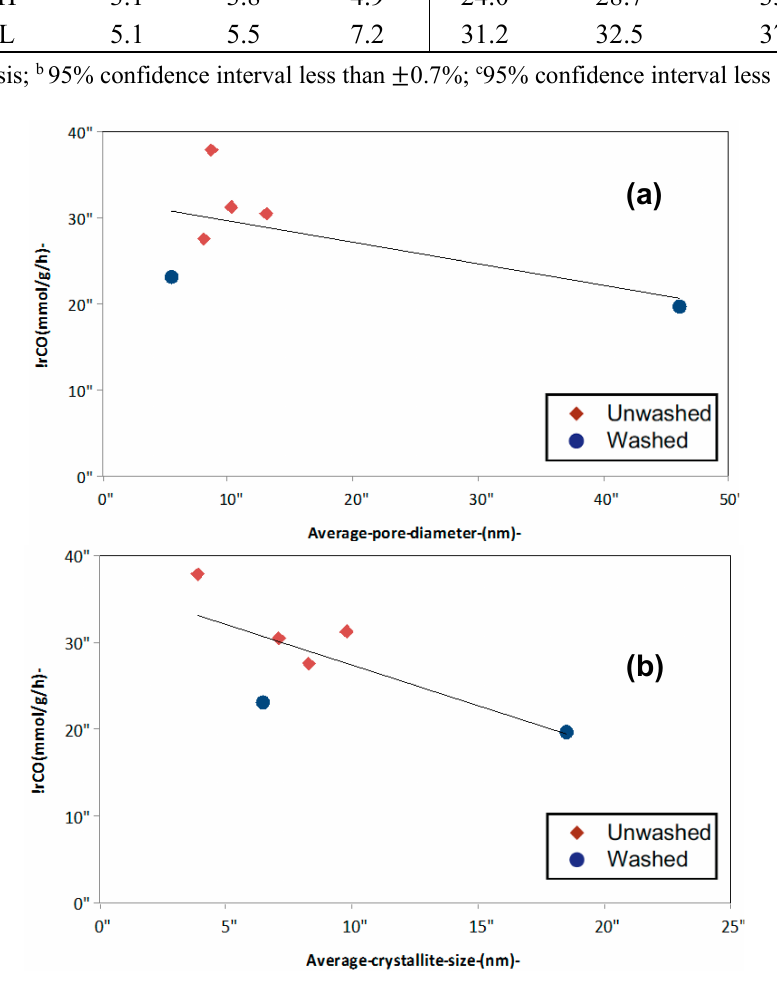
Figure 9. Rate of reaction at 250 °C versus ( a ) average crystallite diameter after reduction and ( b ) average pore diameter after